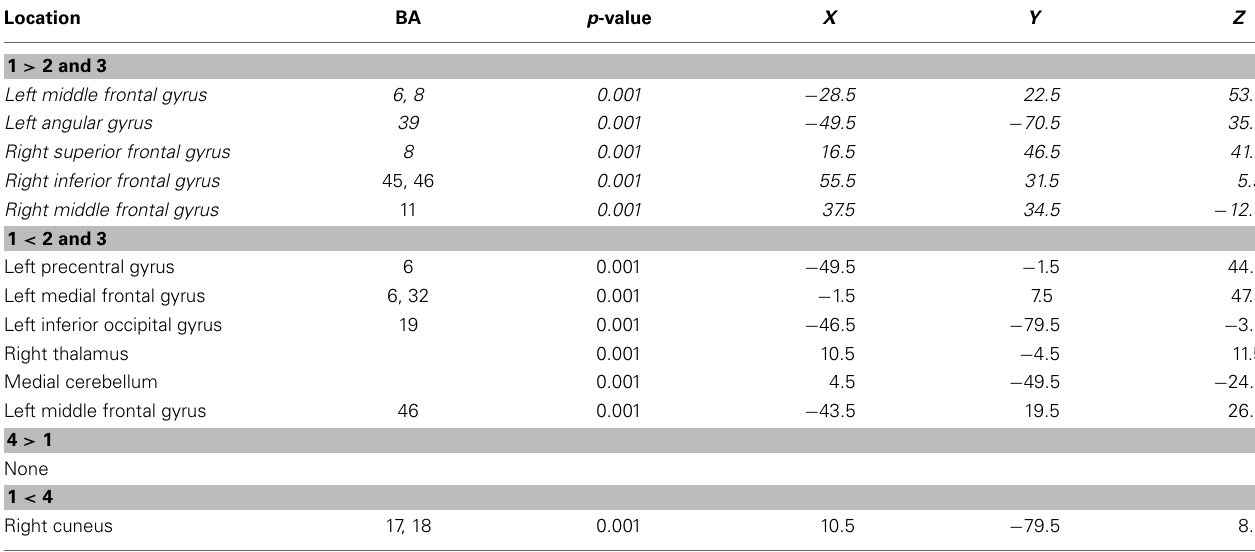
Table 2 | Regions identified during serial position contrasts from the JOP